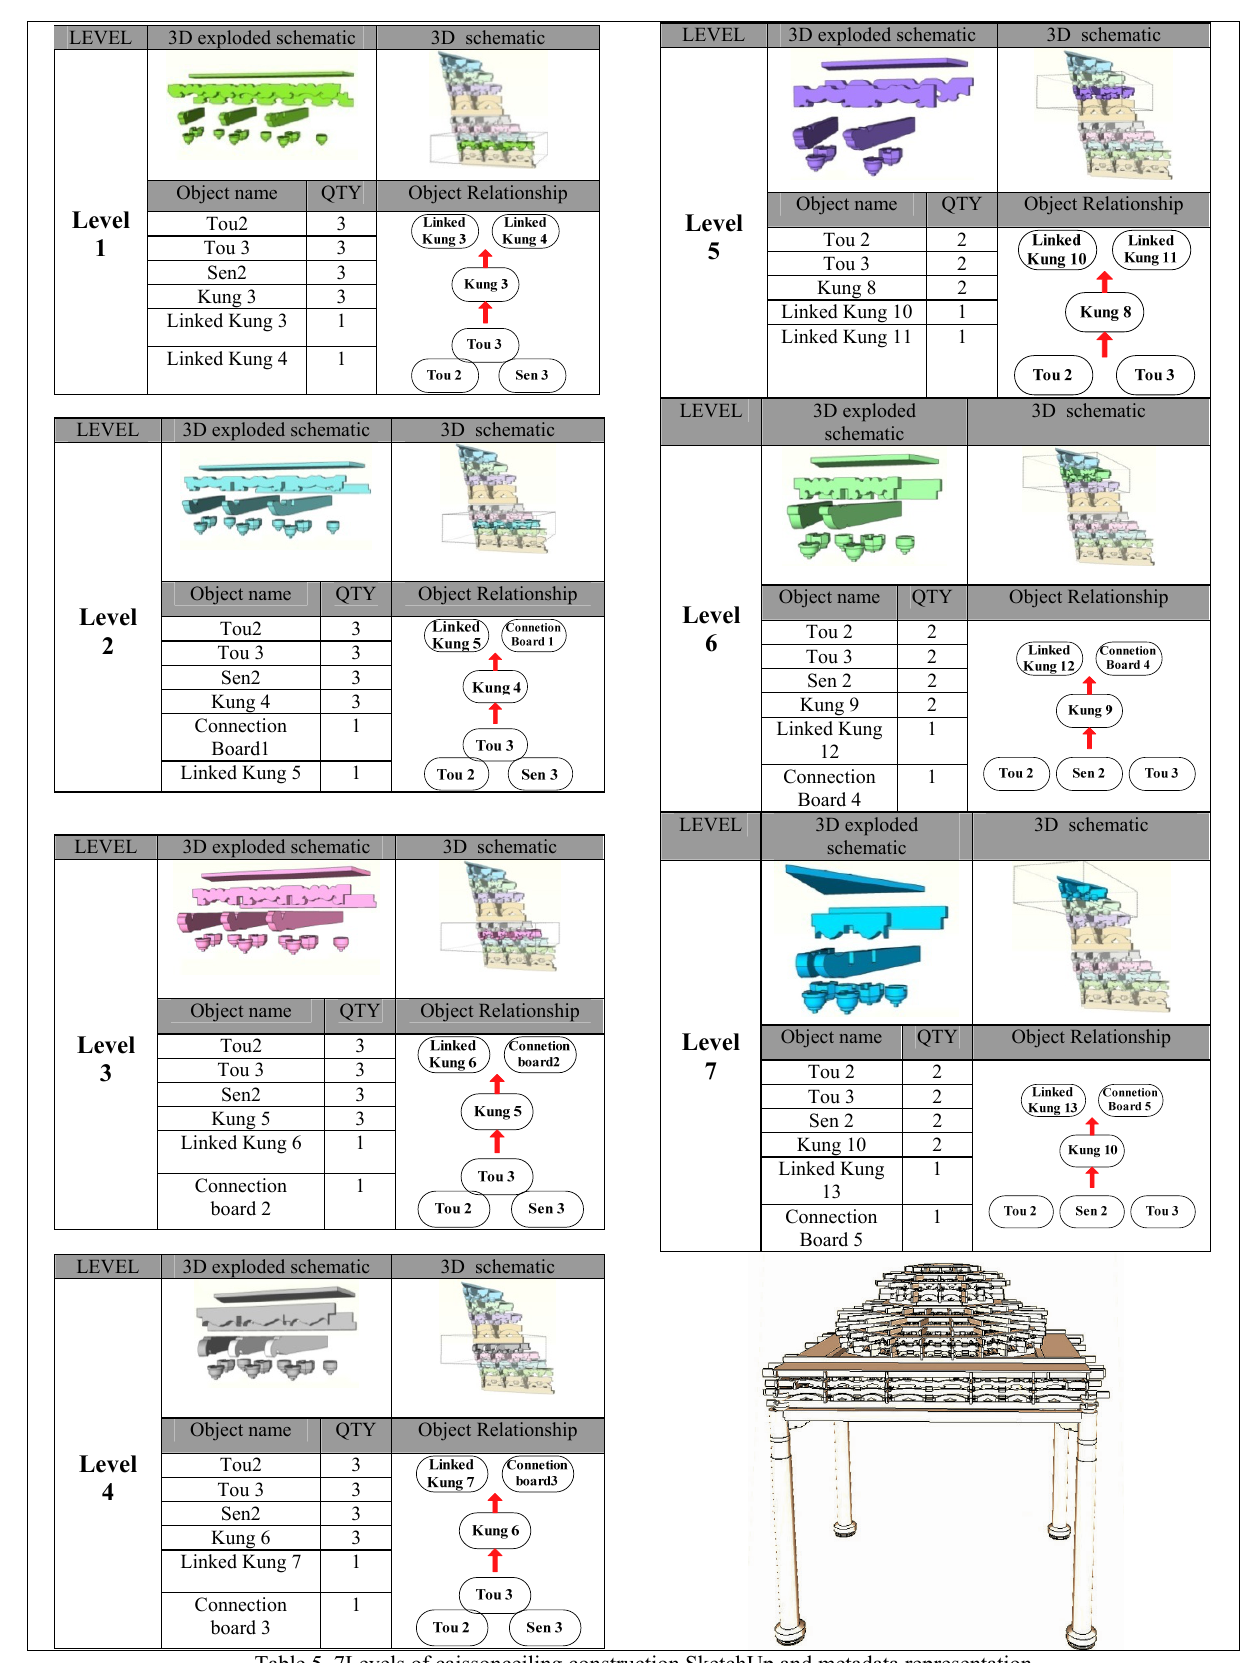
Table 5. 7Levels of caissonceiling construction,SketchUp and metadata